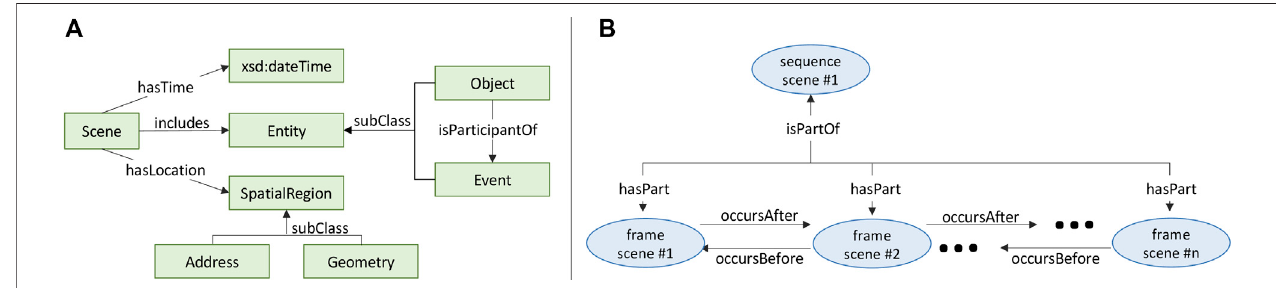
FIGURE 3 | (A) Basic structure of a scene, (B) Two types of scene: sequence scene and frame scene.